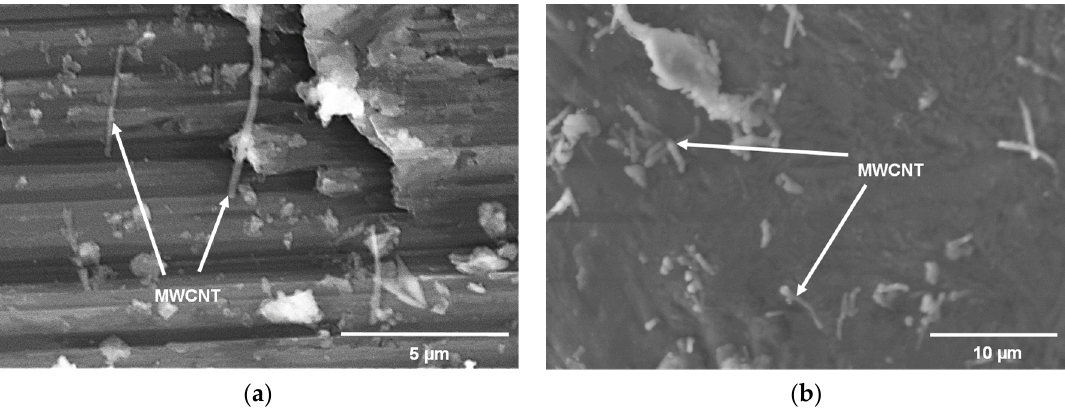
Figure 4. ( a ) Field emission scanning electron microscopes image of dispersion MWCNT on the plateau border; ( b ) Show microstructural observed by field emission scanning electron microscopes about the uniform dispersion of MWCNT in the pore cell-wall. (TU Ilmenau; FG MWV).